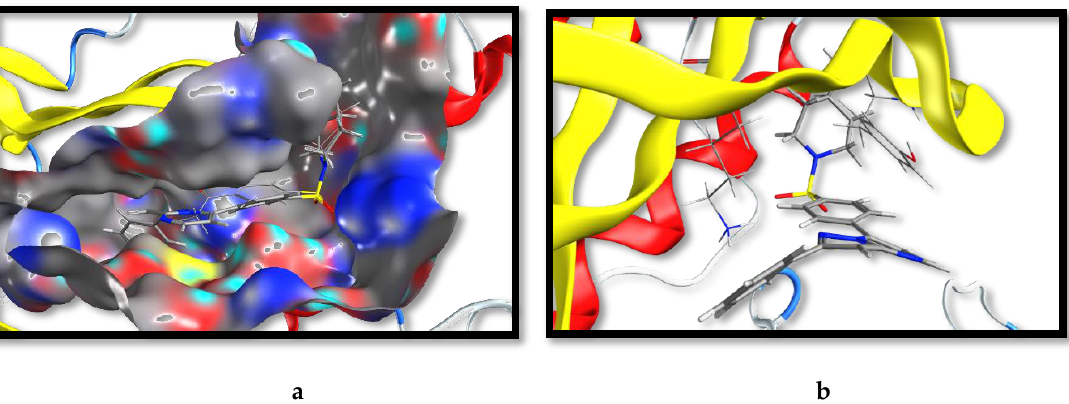
Figure 4. The virtual binding mode of compound 22 at the ERK1 kinase domain. ( a ) The surface representation, illustrating that 22 maintained the original binding pose as 3 , where 22 was extending deep in the pocket. ( b ) The interactions of 22 with amino acid residues at the kinase domain.